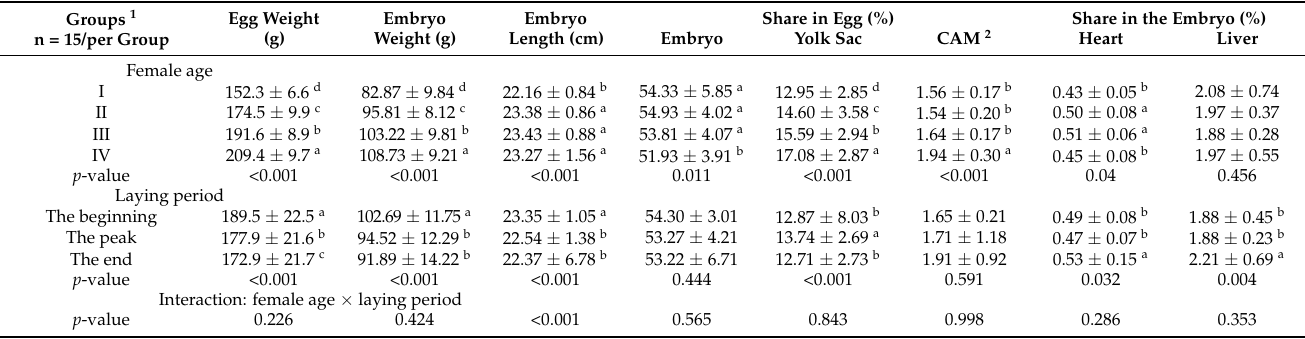
Table 3. Embryonic development of goose embryos on the 28th day of